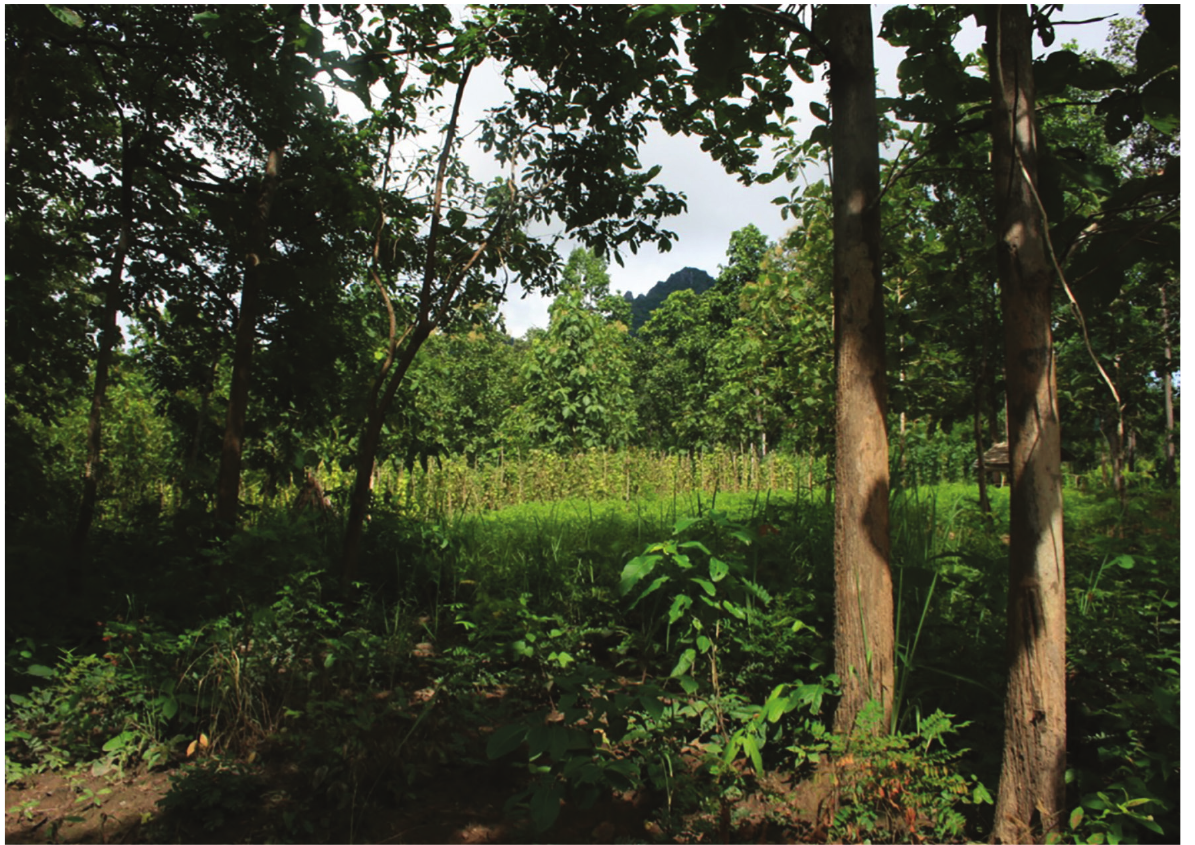
Figure 9. Collecting site of Sacada chaehomensis sp. nov. Thailand, Lampang, Chae Hom, 8.9.2013, photo by Markku